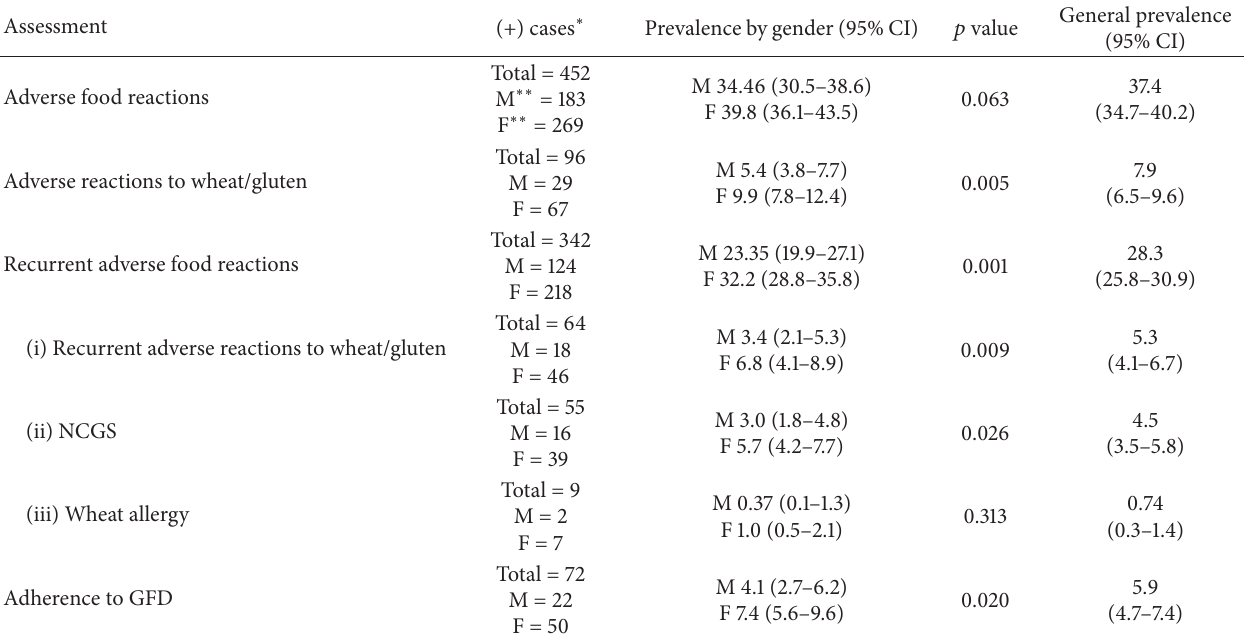
Table 3: Self-reported prevalence rates